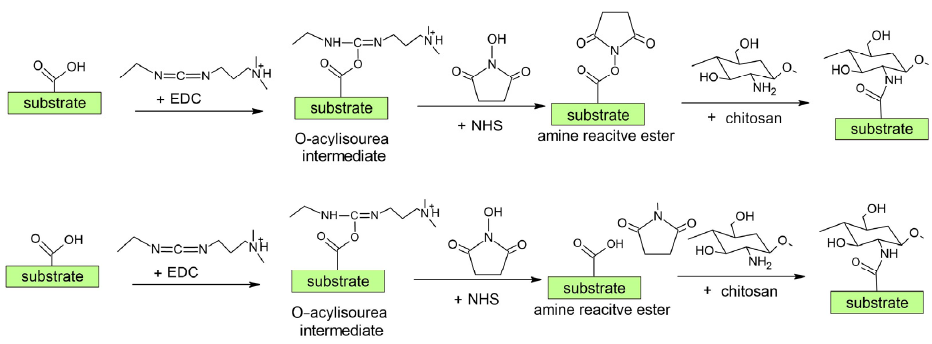
Figure 16. Scheme of the most commonly used procedure for the chemical coupling of chitosan (see Figure 12 also).